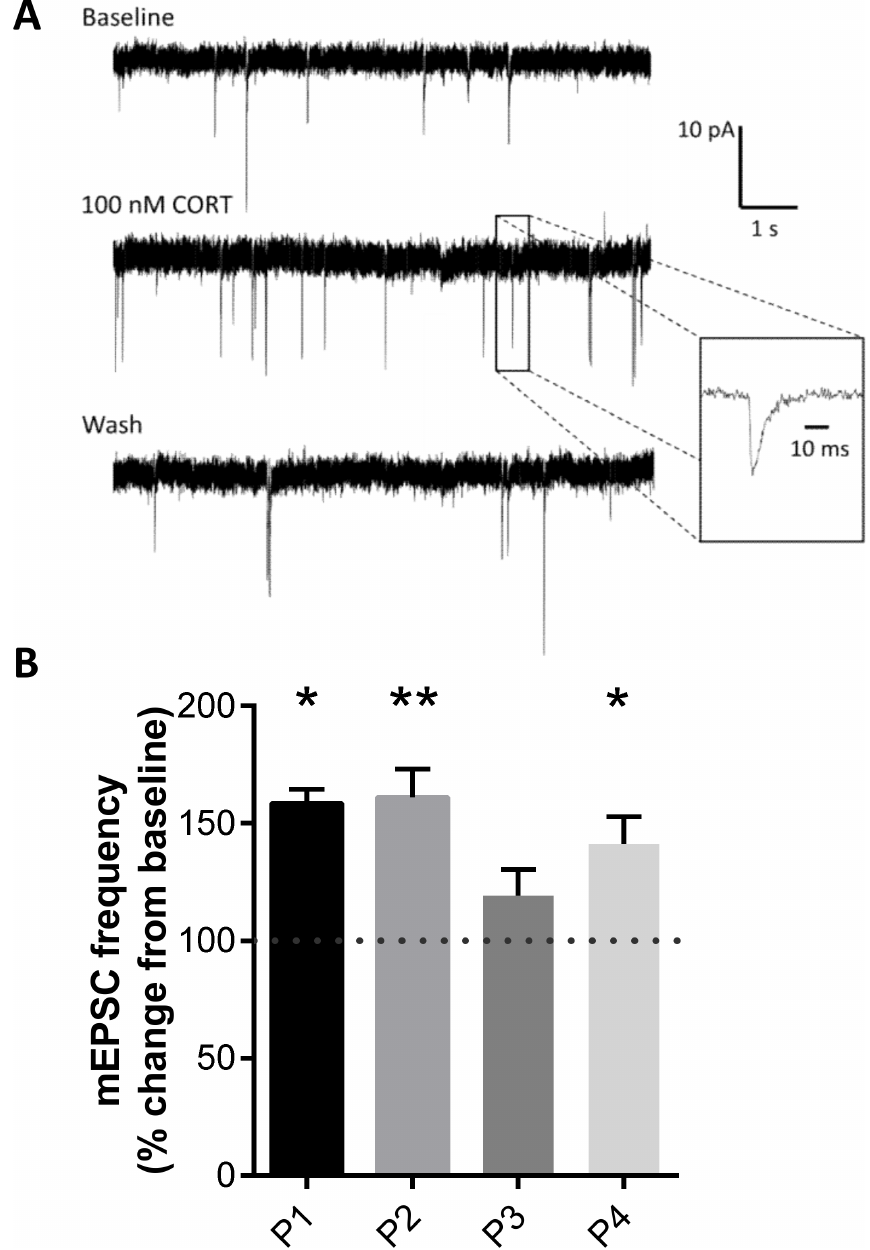
Fig 1. Corticosterone-induced changes in mEPSC frequency (transiently) attenuate. (A)Experimental design. Corticosterone (CORT, 100 nM) or its vehicle was applied for 10 min (thin horizontal arrow), followed by 50 min application of the standard recording buffer. This sequence was repeated four times. For each pulse, the mEPSC properties were recorded during the final 5 min of CORT application (bold vertical arrow) and compared with the properties recorded in the 5 min just prior to hormone application. Statistical analysis is described in the Methods section. A highly similar design was used to determine changes in GluA2 subunit properties during four pulses of CORT; for each pulse this was compared to the values observed just prior to CORT application (see Fig 2). (B) Typical mEPSC trace before, during and 10 min after the first corticosterone application, in an identified CA1 pyramidal cell. An example of a single mEPSC with higher time resolution is shown in the inset. (C) Relative change in mEPSC frequency compared to the pre-pulse baseline (= 100%) after each of four pulses of corticosterone. Data show the mean ± SEM change (n = 6 cells for each pulse). Statistically significant changes in mEPSC frequency due to application of corticosterone (compared to baseline) are indicated by * (p < 0.05) or ** (p <